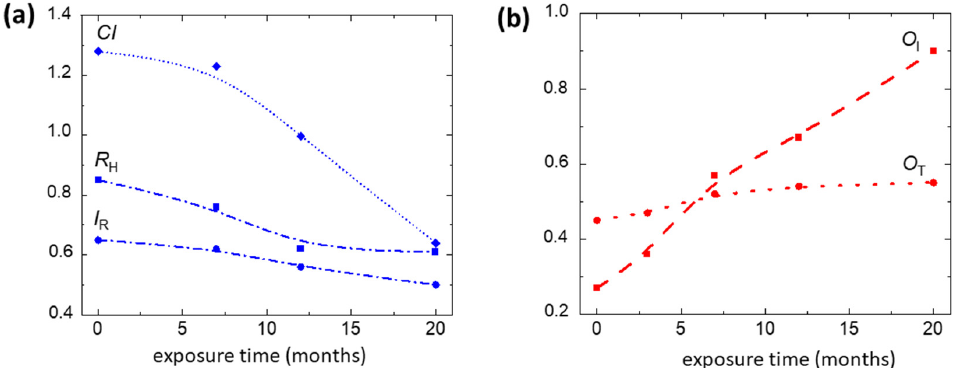
Figure 5. Behavior of the mean values of the ( a ) I R , CI , and R H and ( b ) O I and O T markers, averaged over the distribution, as a function of the exposure time. over the distribution, as a function of the exposure